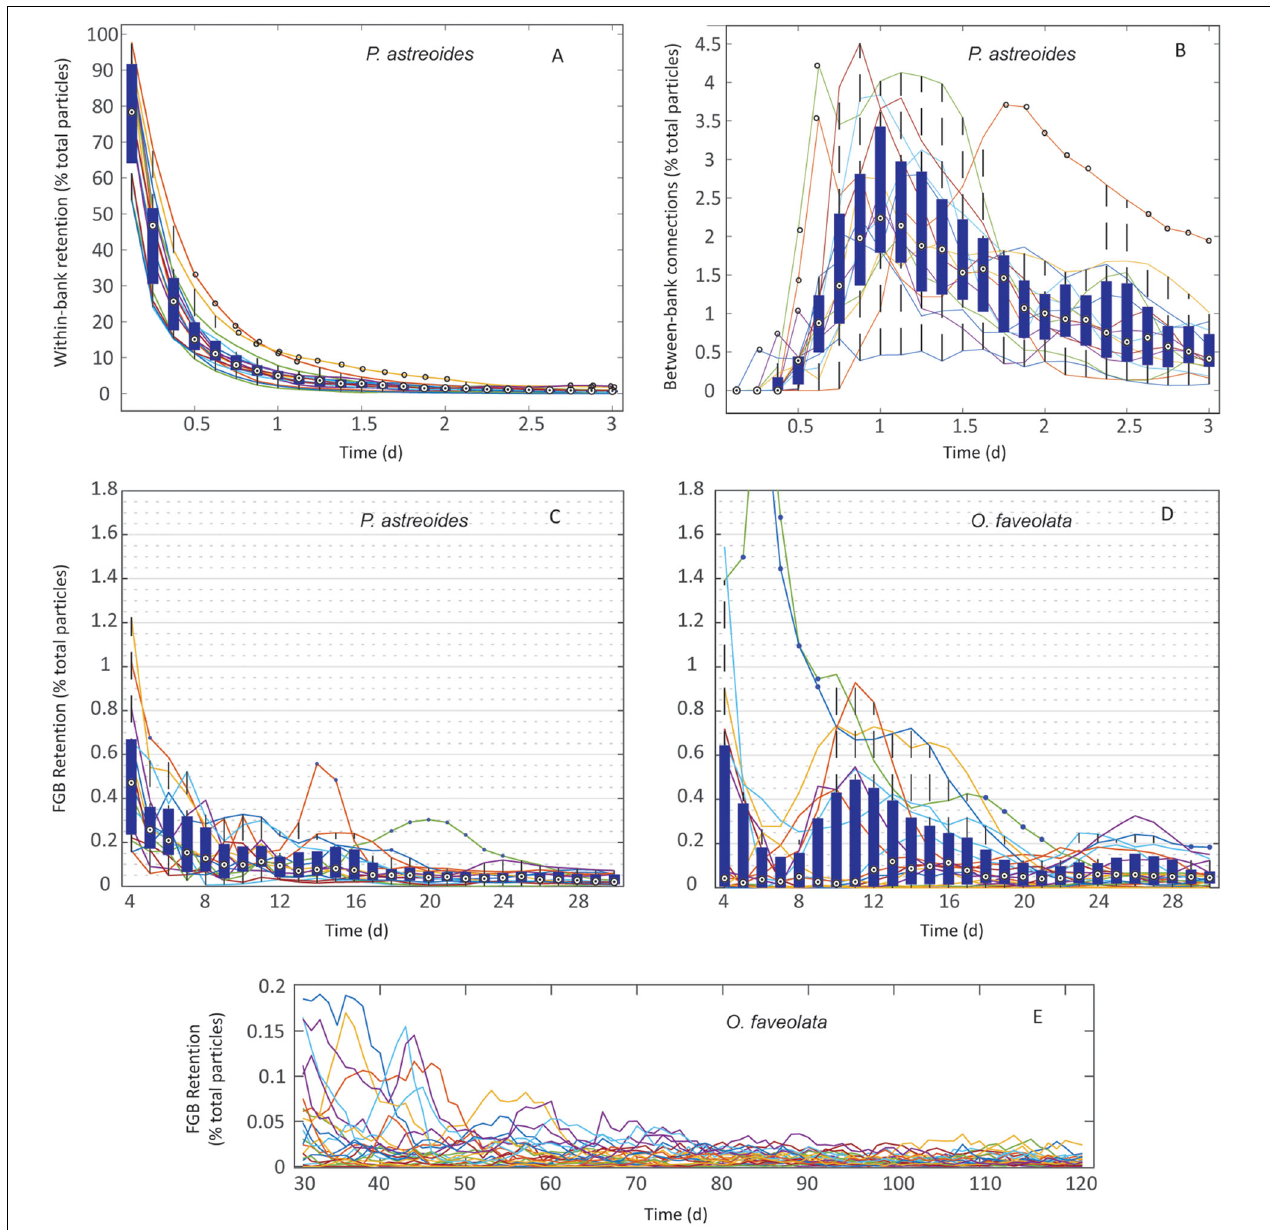
FIGURE 5 | Retention in P. astreoides and O. faveolata at FGB: (A) P. astreoides : 3 h–3 days of within-bank local retention. (B) P. astreoides : 3 h–3 days of between-bank retention. (C) P. astreoides : 3–30 days of dispersal – total FGB retention. (D) O. faveolata : 3–30 days of dispersal – total FGB retention. (E) O. faveolata : 30–120 days of dispersal – total FGB retention. Values represent retention per day as a percentage of total particles released per year. Boxes are interquartile ranges, targets are median values, blue circles are outliers, and whiskers represent the first and fourth quartiles. Lines represent individual years for P. astreoides and individual spawning events for O. faveolata. Note different y -axes scales.